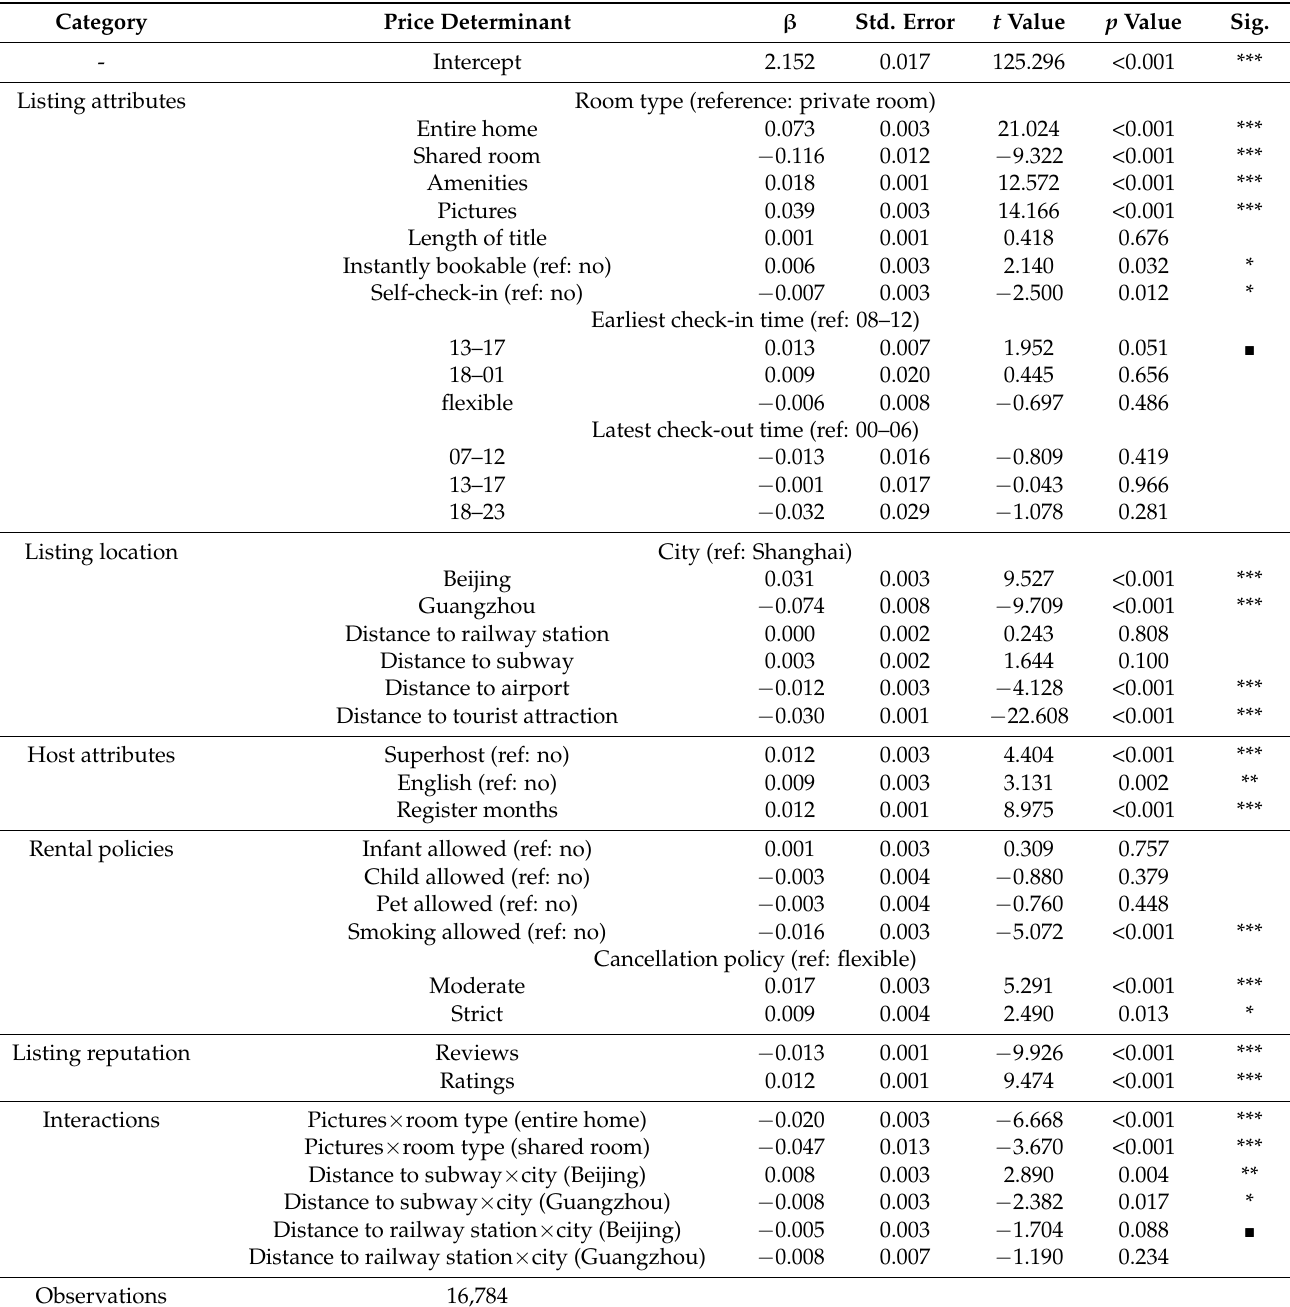
Table 6. Regression results of Model